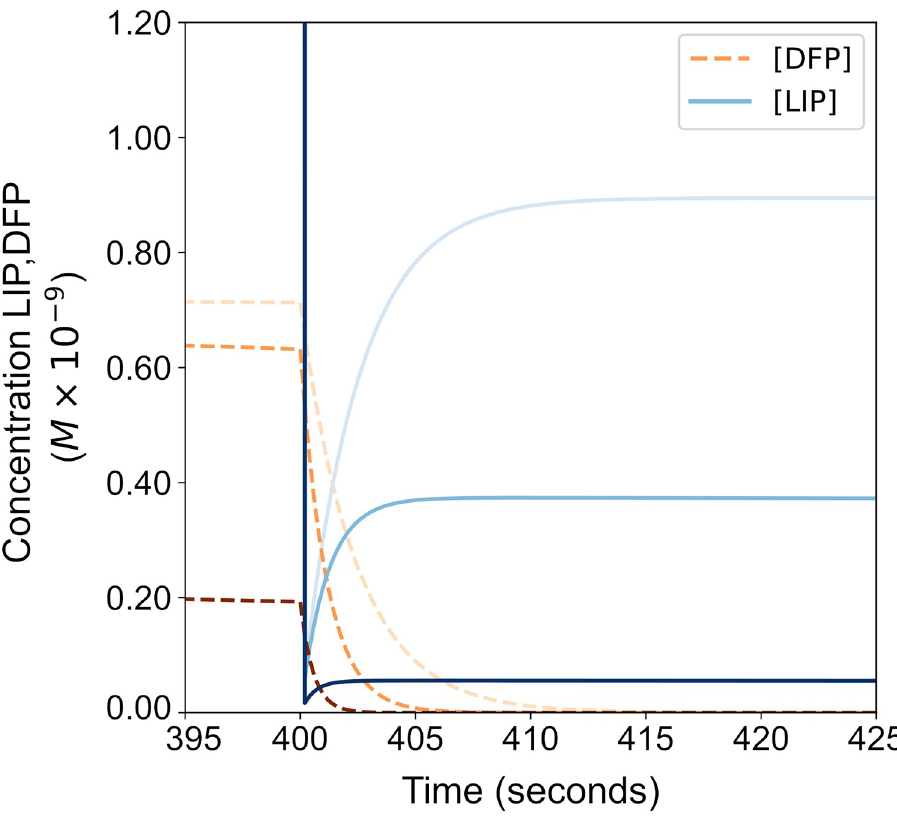
Fig 5. Iron release from FT after LIP reduction. At time 400 second the LIP was eliminated (reduced to 0 M) and the resulting DFP and LIP concentrations are plotted as iron is liberated from FT. Each curve indicates a simulation run at a FT concentration (5nM, 20nM, 50nM) (darker color is a higher FT concentration).